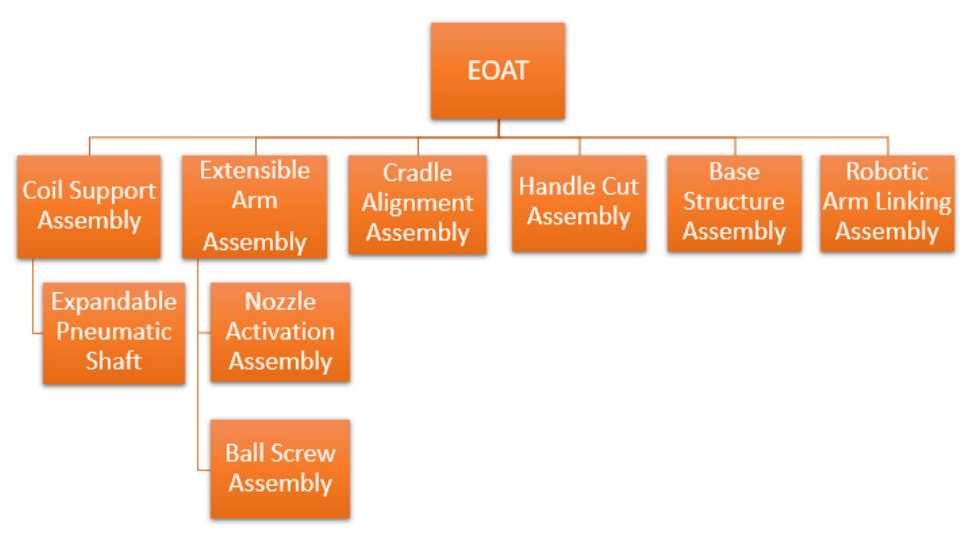
Figure 5. Diagram of EOAT’s sub-assemblies.